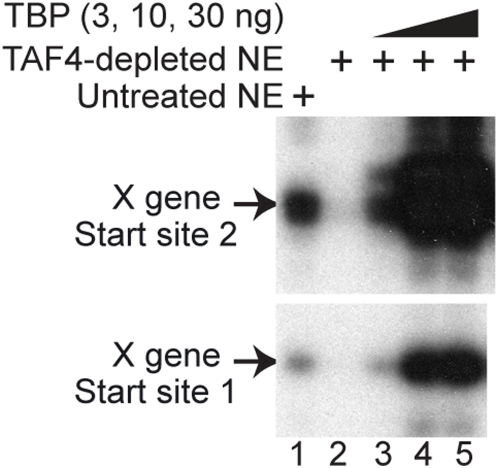
A free form of TBP can drive X gene transcription in the absence of TAF4.HeLa NE was depleted with nothing (lane 1) or with anti-TAF4 (lanes 2–5) and was mixed with the indicated amounts of purified recombinant TBP (lanes 3–5), then tested for X gene transcription activity.